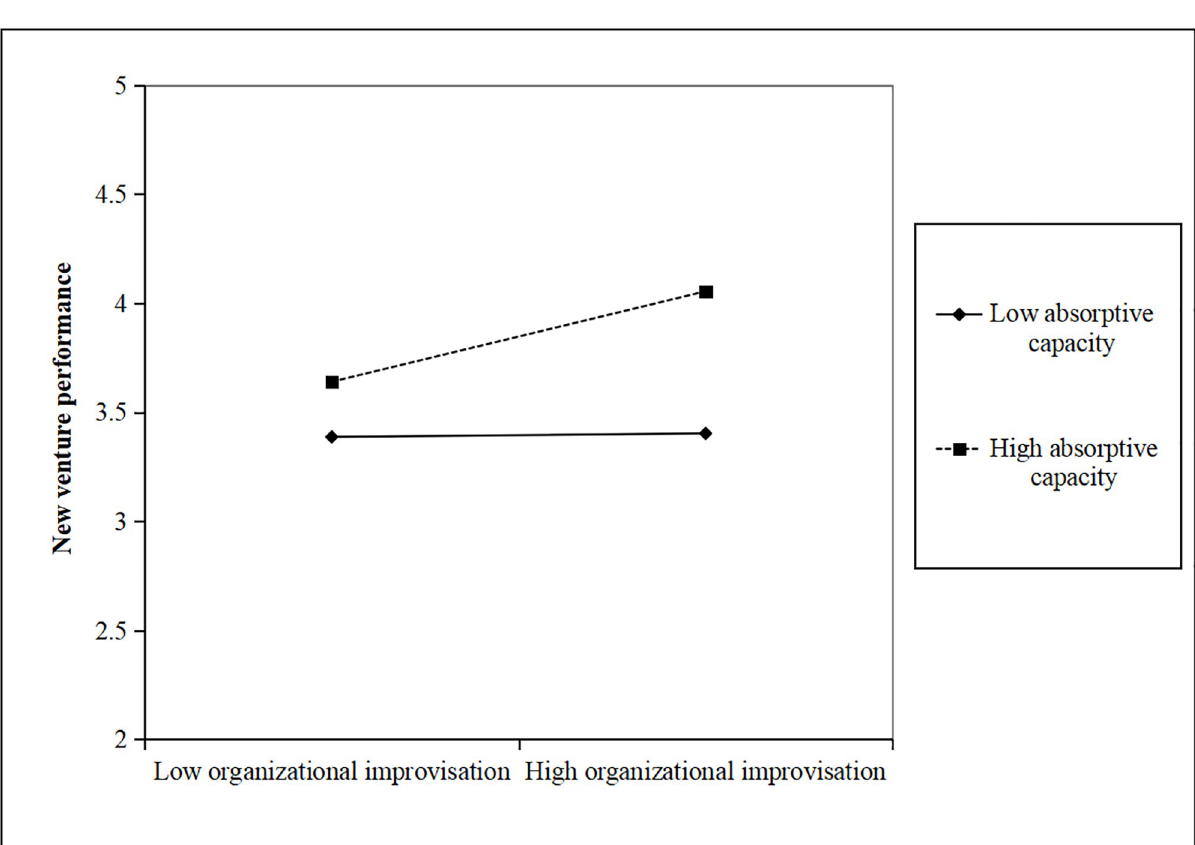
Fig 2. The moderating effect of absorptive capacity.